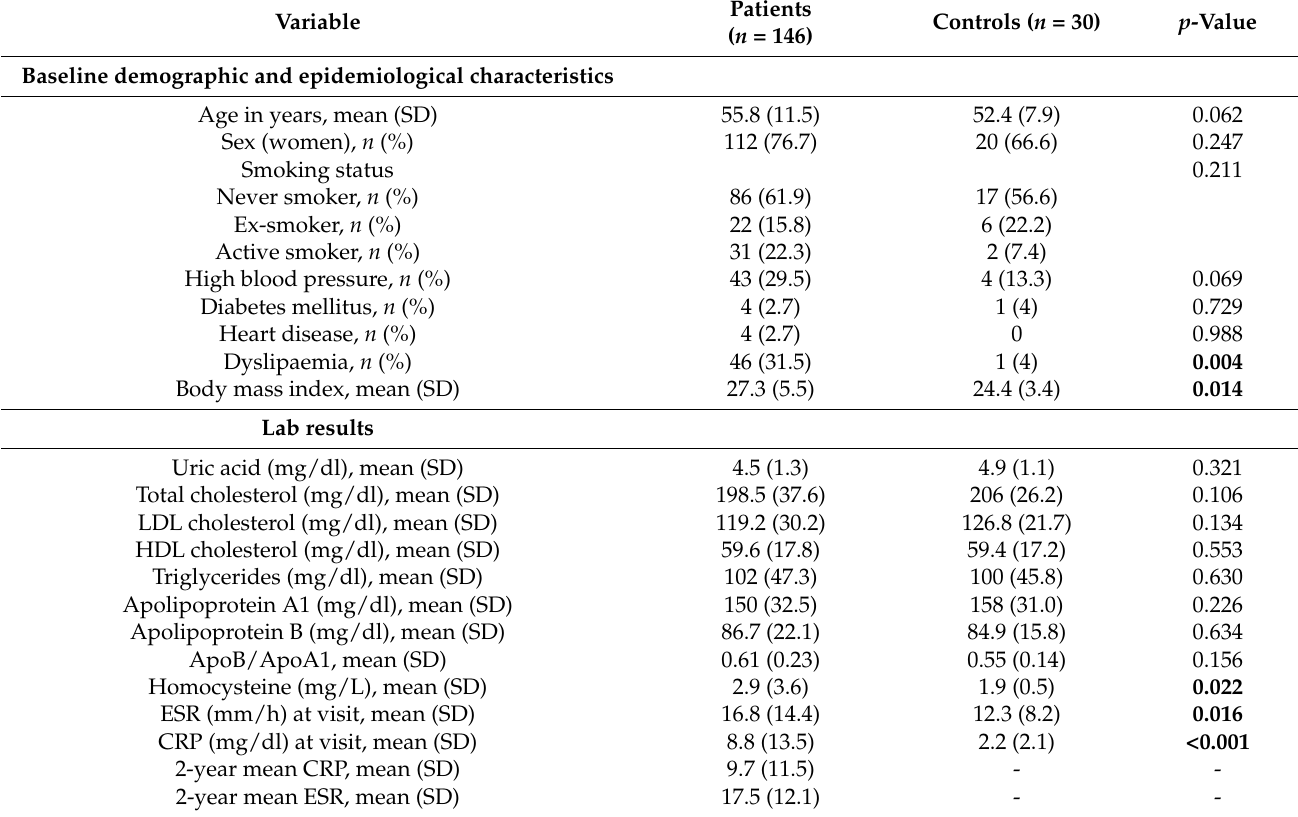
Table 1. Baseline demographic and epidemiological characteristics, comorbidities, lab results and carotid ultrasound findings in patients and